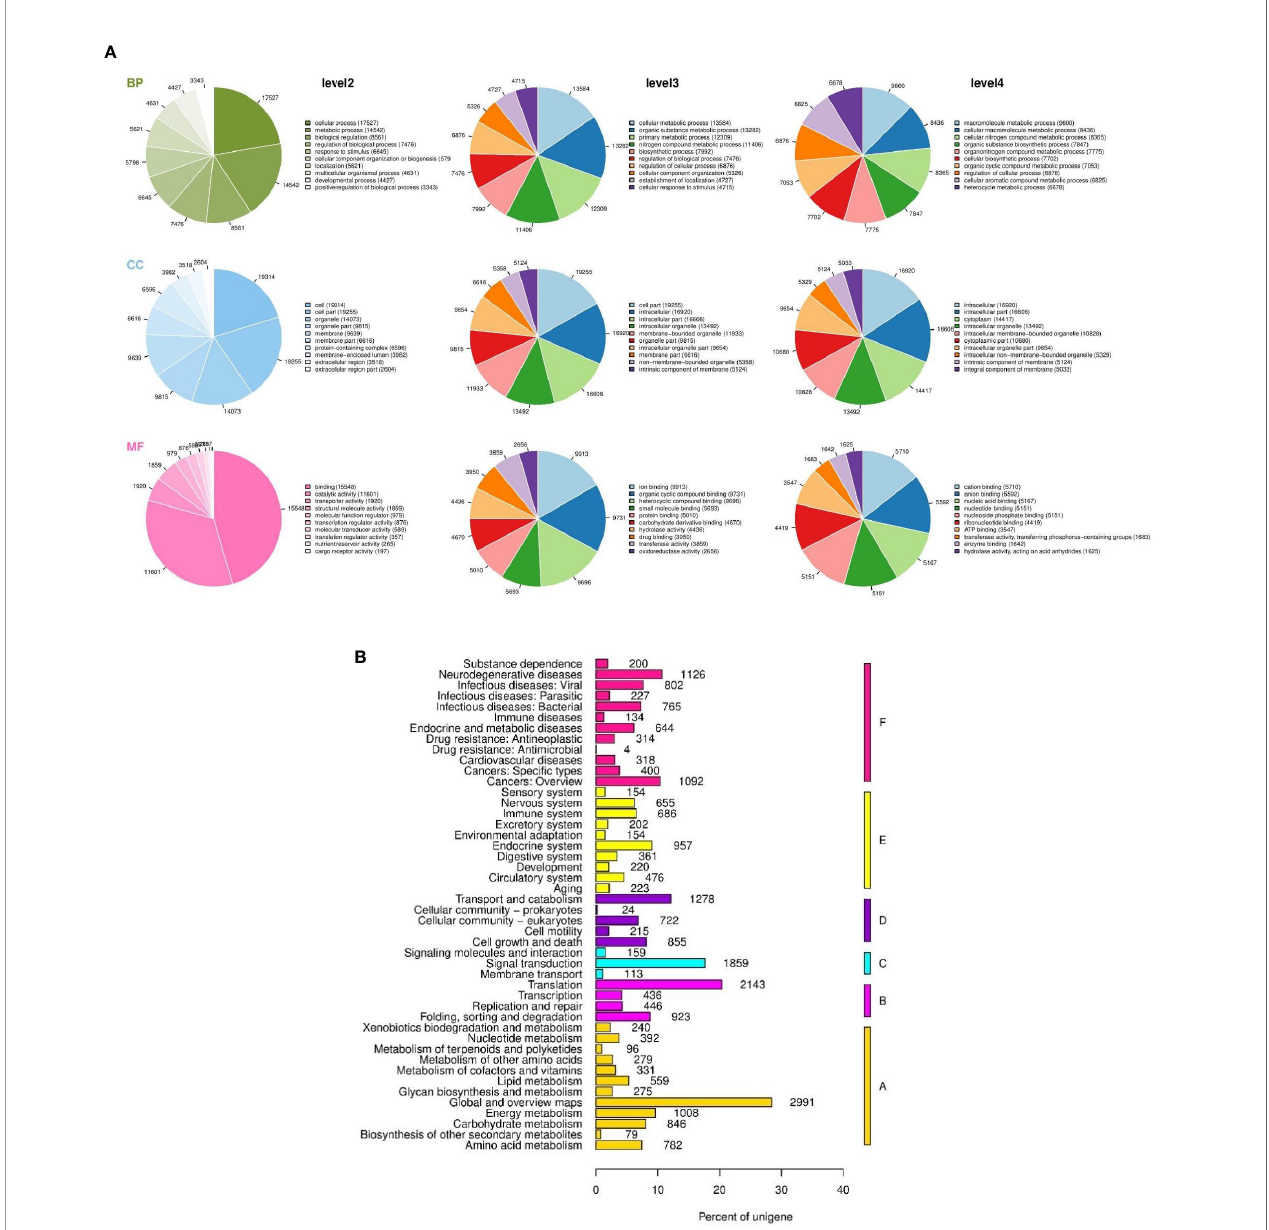
FIGURE 2 | Global transcriptomic analysis of Strongylocentrotus intermedius gonads. (A) GO annotation in level 2, 3 and 4, BP, biological process; CC, cellular component; MF, molecular function. (B) Unigenes homology to KEGG, A: metabolism: B: genetic information processing; C: environmental information processing; D: cellular processes; E: organismal systems; F: human